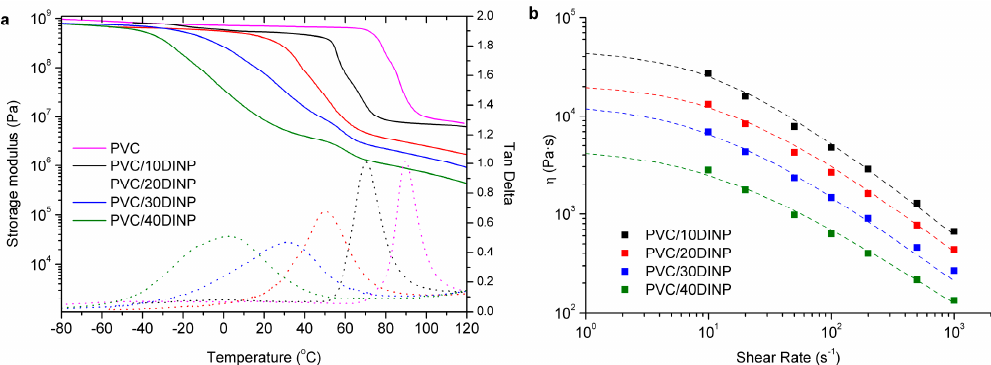
Figure 1. ( a ) Elastic modulus and loss tangent as a function of temperature at a constant frequency of 1 Hz. ( b ) Viscosity as a function of shear rate at 180 °C. The compositions are